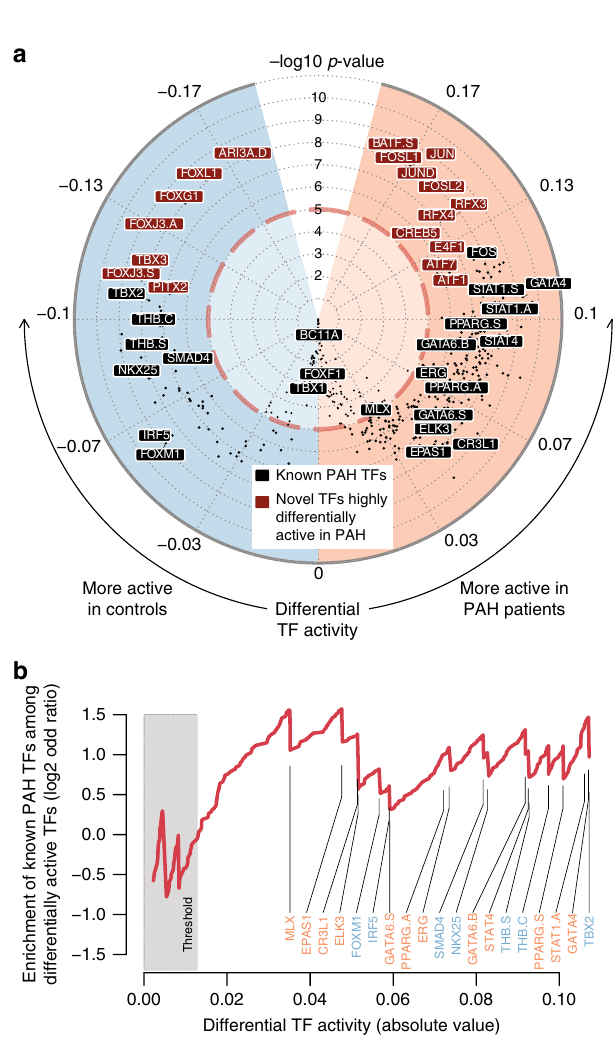
Fig. 3 Differential TF binding activity between PAH and controls. a Circular vulcano-plot shows the distribution of differential TF activity based on H3K27ac signal differences between PAH and controls. TFs previously associated with PAH are labeled in black. TFs that are more differentially active between patients and controls than the known PAH-TFs are labeled in red. Full list of differentially active TFs are provided in Supplementary Data 3. b Enrichment of known TFs related to PAH among the set of differentially active TFs for increasing thresholds for de fi ning differential TF activity. TF activity is shown on an absolute scale with TFs being more active in patients and controls colored in orange and blue,